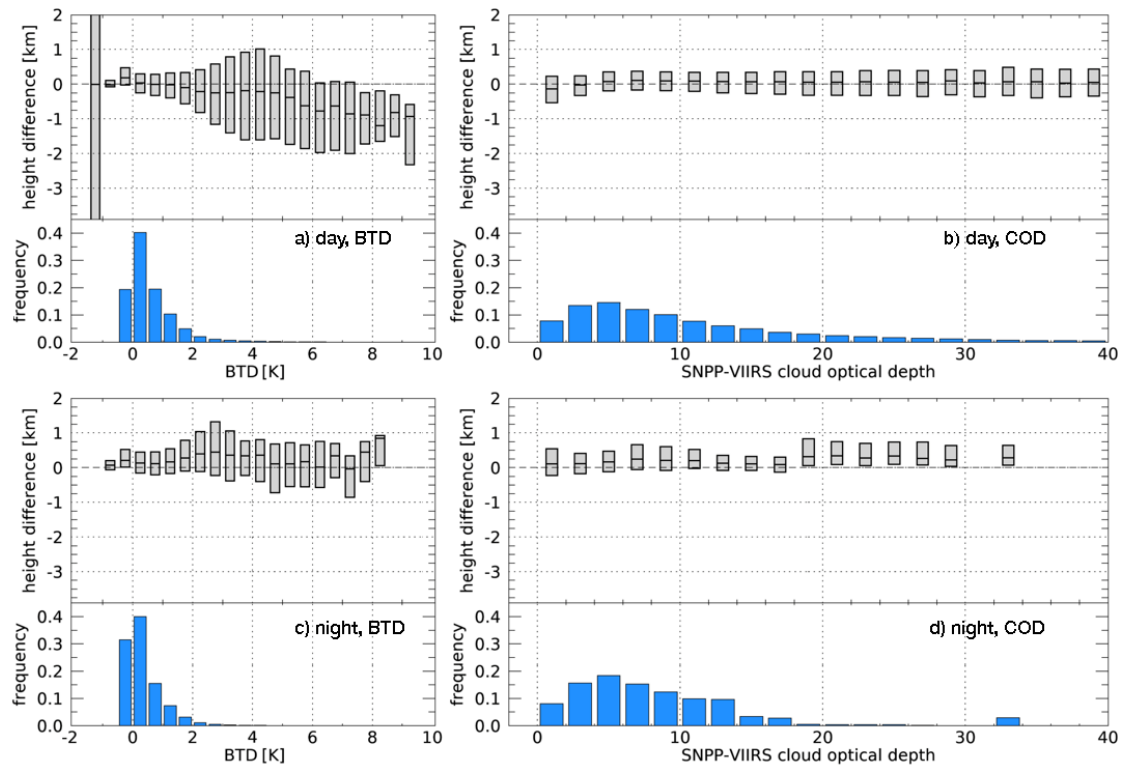
Figure 15. Histograms of SIF ocean CTH differences as a function of the brightness temperature differences (BTD) between the VIIRS 11 and 12 µm channels ( a , c ) and the CV1S cloud optical depth ( b , d ) from daytime ( a , b ) and nighttime ( c , d ) data for 0/100 SL overcast liquid water clouds, JAJO 2015–2016. Fractional frequencies of occurrence are provided in the bottom portion of each plot. Mean differences are indicated by horizontal lines in each bar. Shaded area indicates the range of data for each